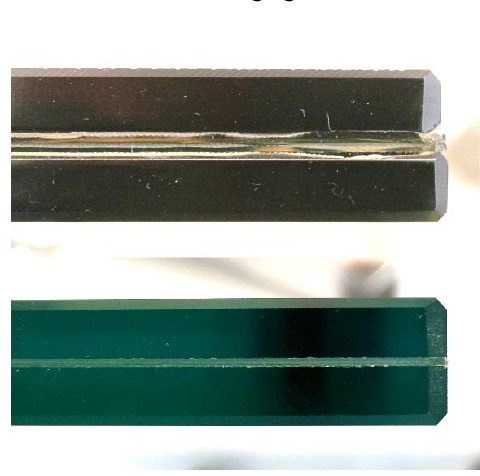
Fig. 1 Details of a laminated glass with an edge offset (top) and with a reground edge